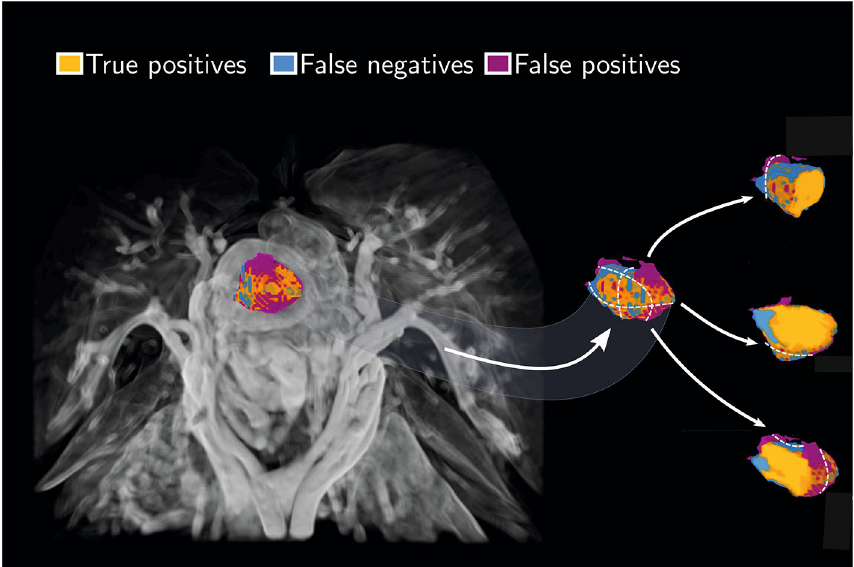
Figure 1. Volume rendering (left panel) of manual and automated ML segmentation of the primary tumor from one patient in terms of true positives (orange), false negatives (blue), and false positives (purple). The 3D segmentation is shown along with the gradient-enhanced 3D volume rendering of the T1-weighted VIBE sequence as a background image. Furthermore, three separate paraxial slices from the same data set are depicted together with a close-up view of the tumor and outlined segmentations (right panel). A majority of the false predictions occur in the tumor periphery, indicated with blue and purple labels. The white, dotted lines are the three orthogonal cutting planes used for creating the corresponding slicing